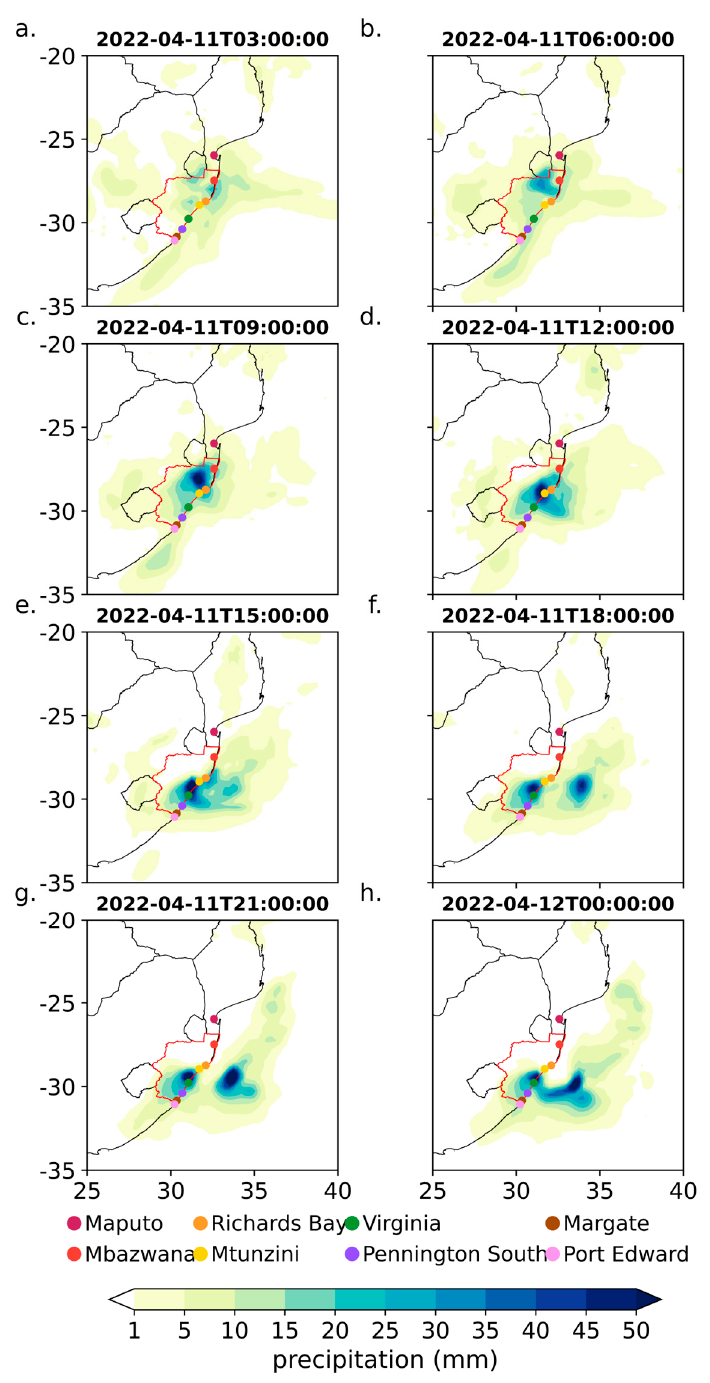
Figure 5. ERA5 precipitation (shaded; mm) accumulated at 3 hourly intervals and shown for ( a ) 0300 UTC, ( b ) 0600 UTC, ( c ) 0900 UTC, ( d ) 1200 UTC, ( e ) 1500 UTC, ( f ) 1800 UTC, ( g ) 2100 UTC on 11 April 2022 and ending at ( h ) 0000 UTC 12 April 2022. The locations of the stations discussed in the text are depicted by the coloured circles.